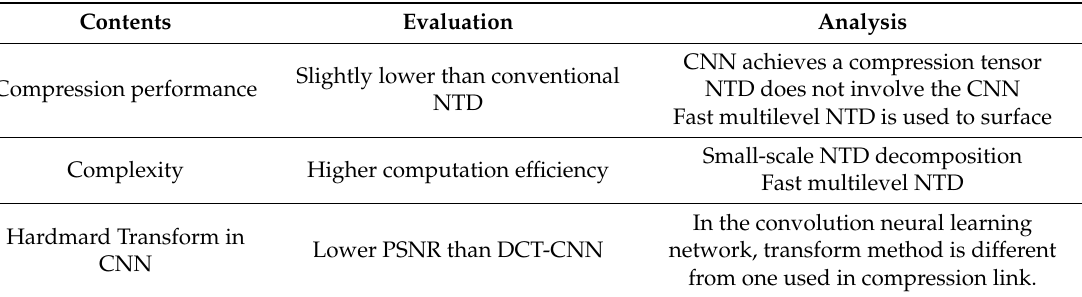
Table 6. Evaluation of the proposed compression